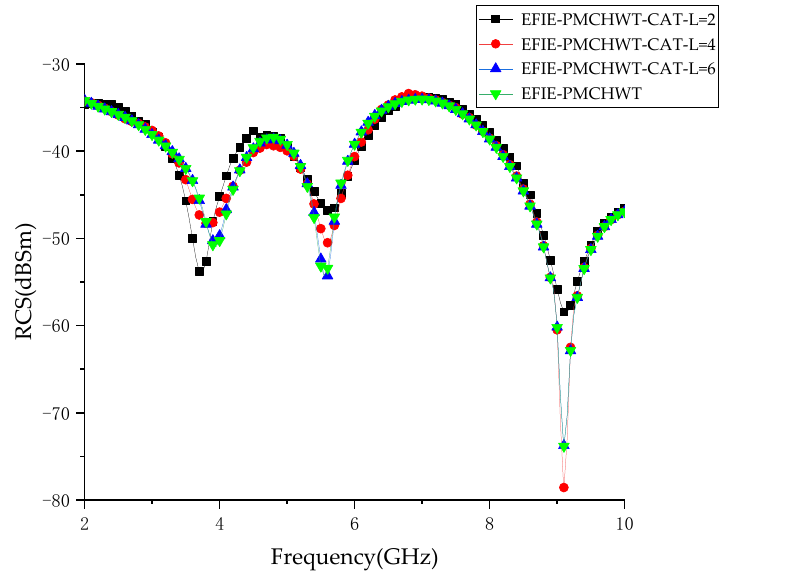
Figure 11. RCS frequency response of the coated boat by using three different orders of EFIE- PMCHWT-CAT and EFIE-PMCHWT.